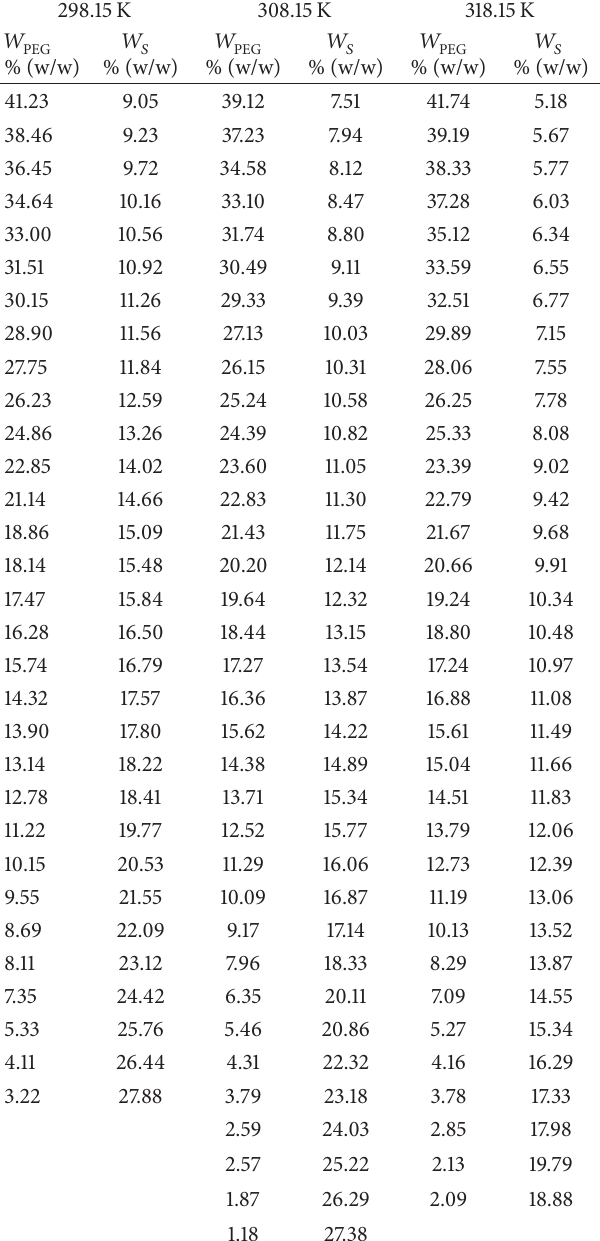
Table 1: Binodal data for the PEG 6000 + sodium succinate + water system at different temperatures. 298.15 K 308.15 K 318.15K